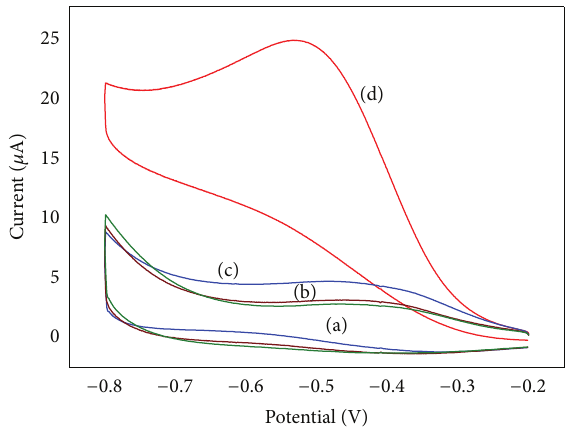
Figure 4: Cyclic voltammetry of (a) Nafion/HRP/Mg-TND-6 elec- trode, (b) Nafion/HRP/Mg-TND-4 electrode, (c) Nafion/HRP/Mg- TND-2 electrode in 0.1 M PBS (pH = 7.0) and 0.1V ⋅ s −1 scan rate, and (d) Nafion/HRP/TND-3 electrode in 0.1M PBS (pH = 7.0) with 100 𝜇 M H 2 O 2 and 0.1 V ⋅ s −1 scan